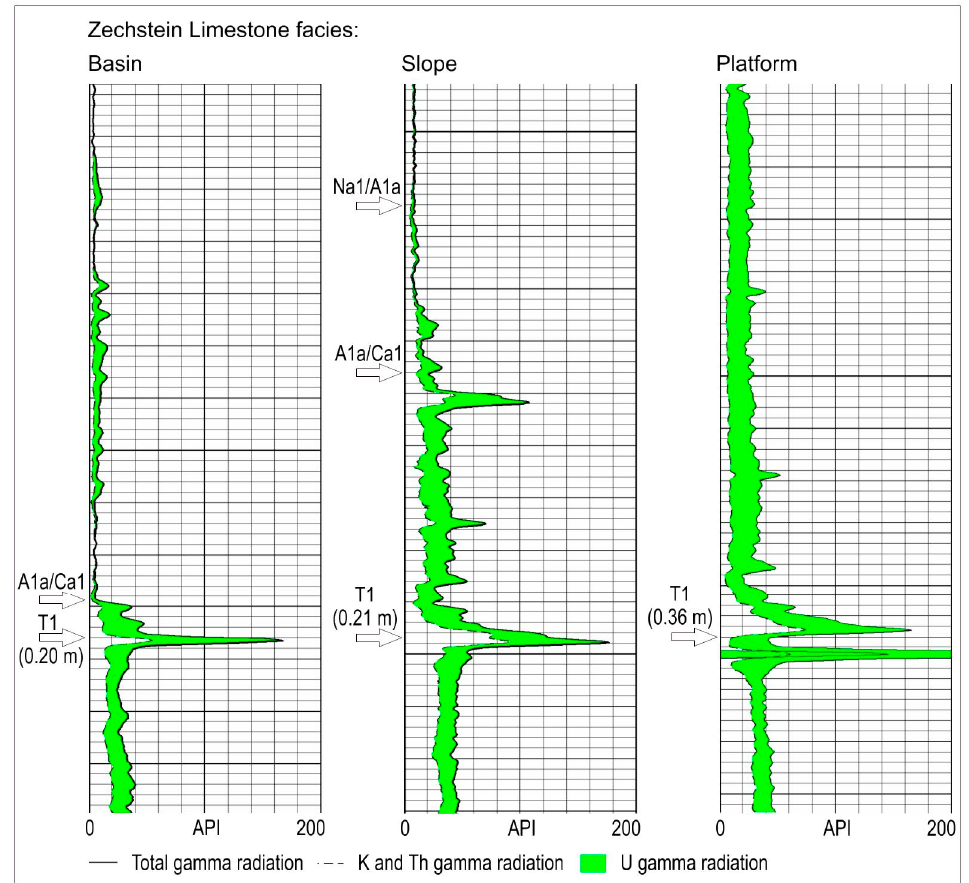
Figure 6. Examples of natural gamma radiation profiles: total, U, and K + Th, with lithostratigraphic boundaries (according to: [62–64]).